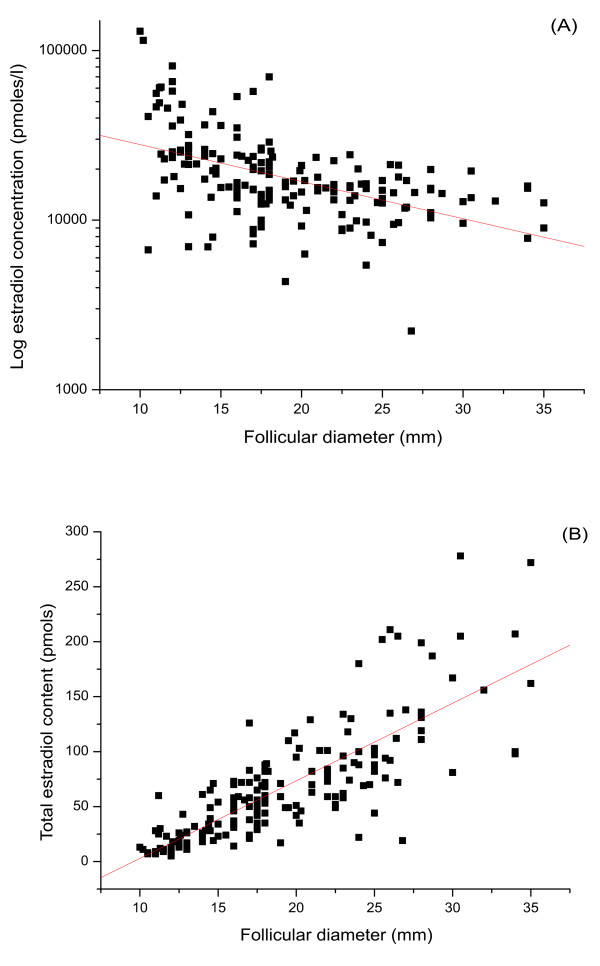
Follicular estradiol. Scatter plots to show the correlation of estradiol concentration (pmoles/L) (a) and total content (pmoles) (b) with follicular diameter (mm). Estradiol concentration significantly decreased with follicular size increase (2a: r = 0.5, p < 0.001); while estradiol total content increased dramatically when corrected by follicular volume (2b: r = 0.79, p < 0.001).